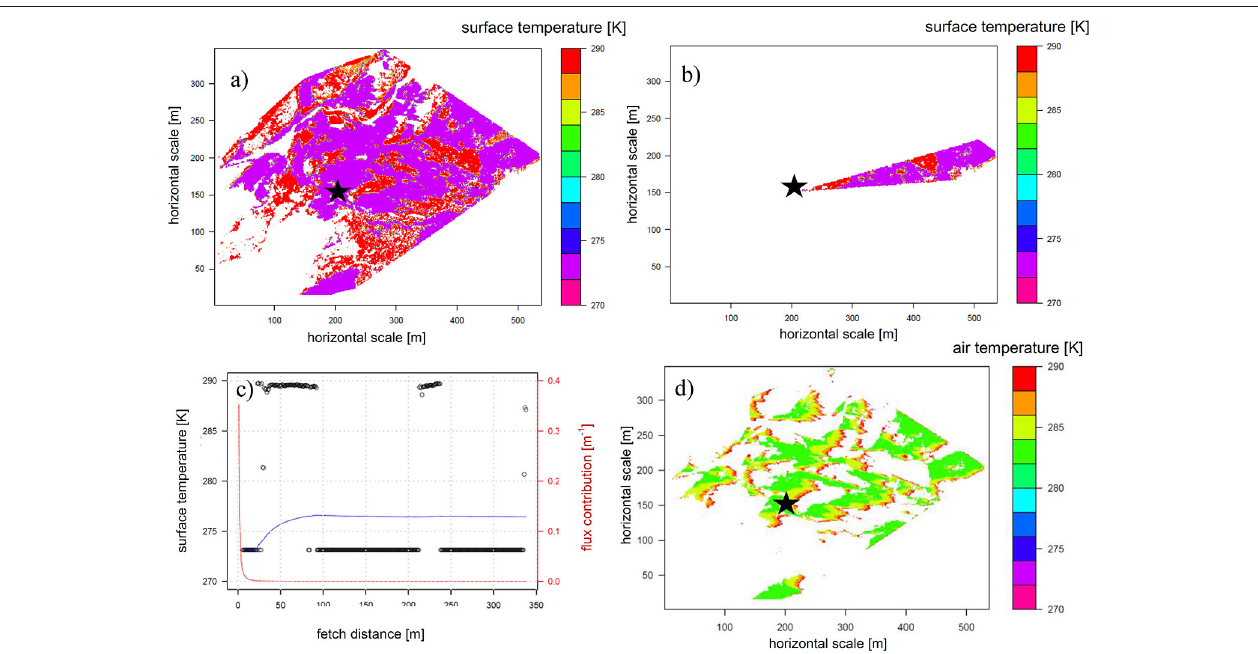
FIGURE 3 | Stepwise explanation of the temperature footprint approach for one time step (21 May 2014, 12 UTC): (a) Alpine3D modeled surface temperatures [K] at the Gletschboden area. (b) Upwind sector shown exemplarily for one pixel ( x = 200, y = 150, black star). (c) Averaged surface temperatures as a function of the fetch distance for a chosen pixel T S ( x L ) 200,150 (black points), right y-axis). (d) Near-surface air temperatures after the application of the temperature footprint approach [K] for the Gletschboden